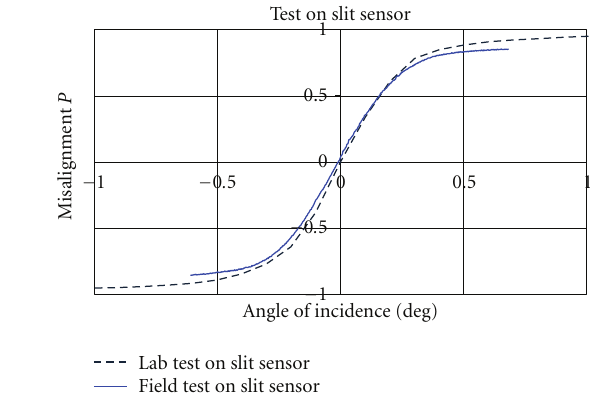
Figure 14: Lab and filed tests for Slit Sensor.